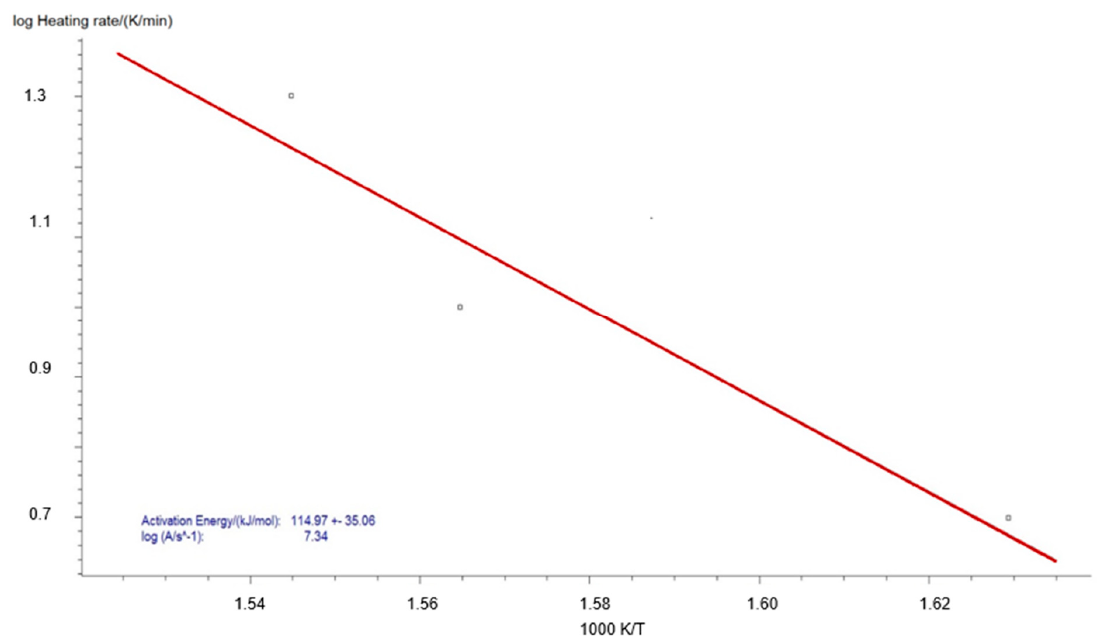
Figure A1. Kissinger analysis (ASTM E698) for pine wood.